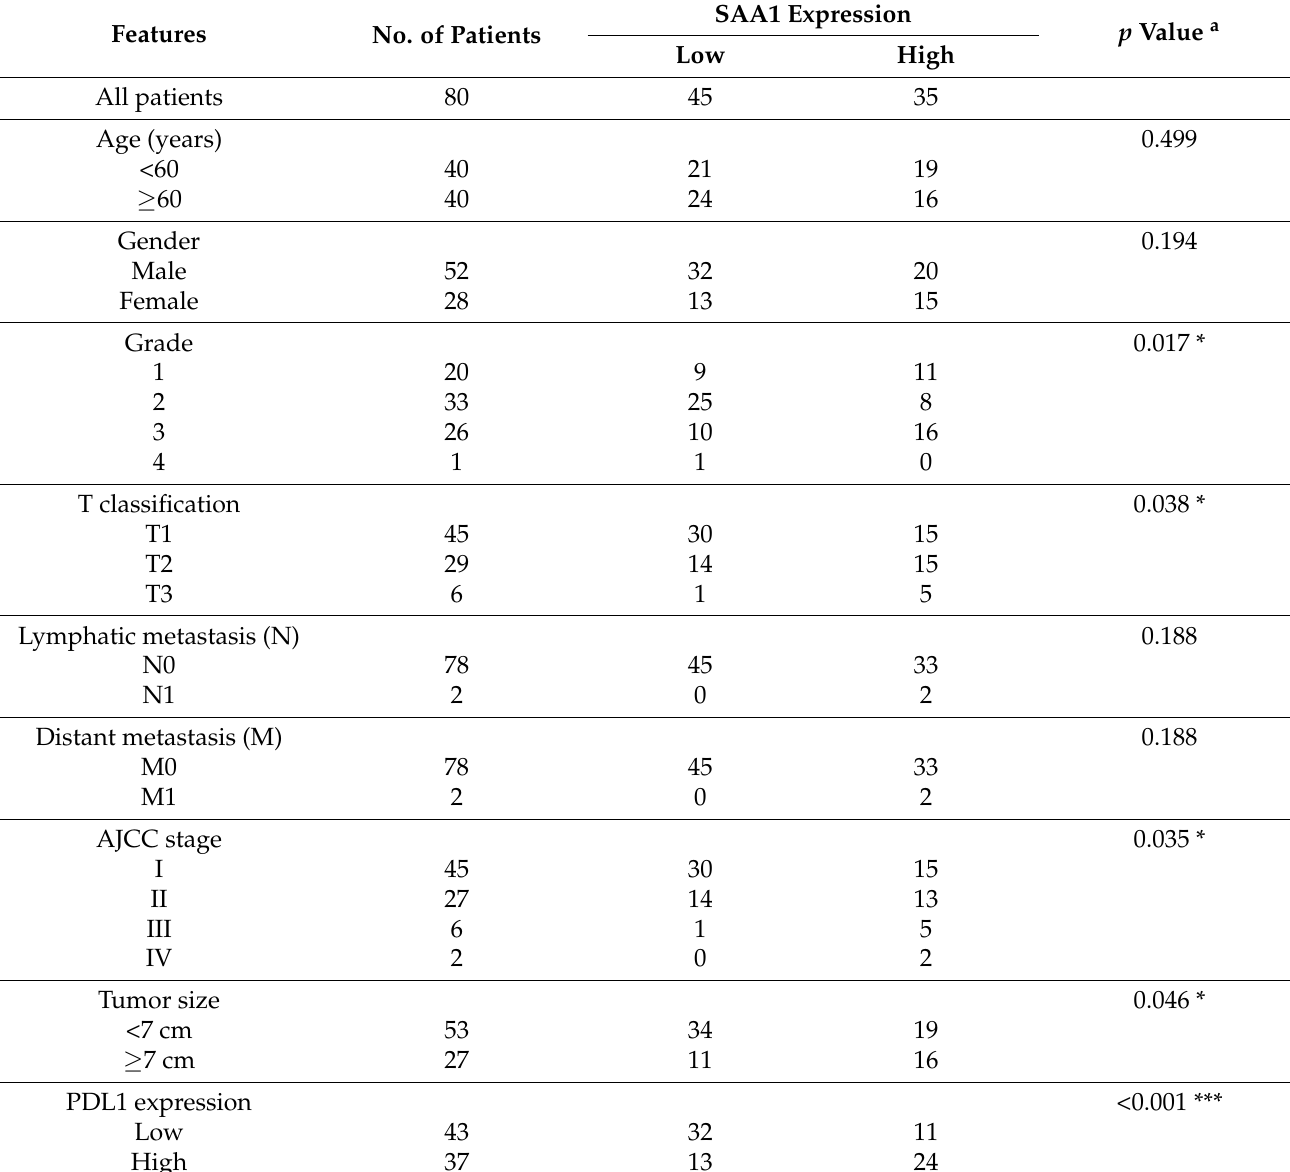
Table 1. Relationship between SAA1 Expression and Tumor Characteristics in Patients with